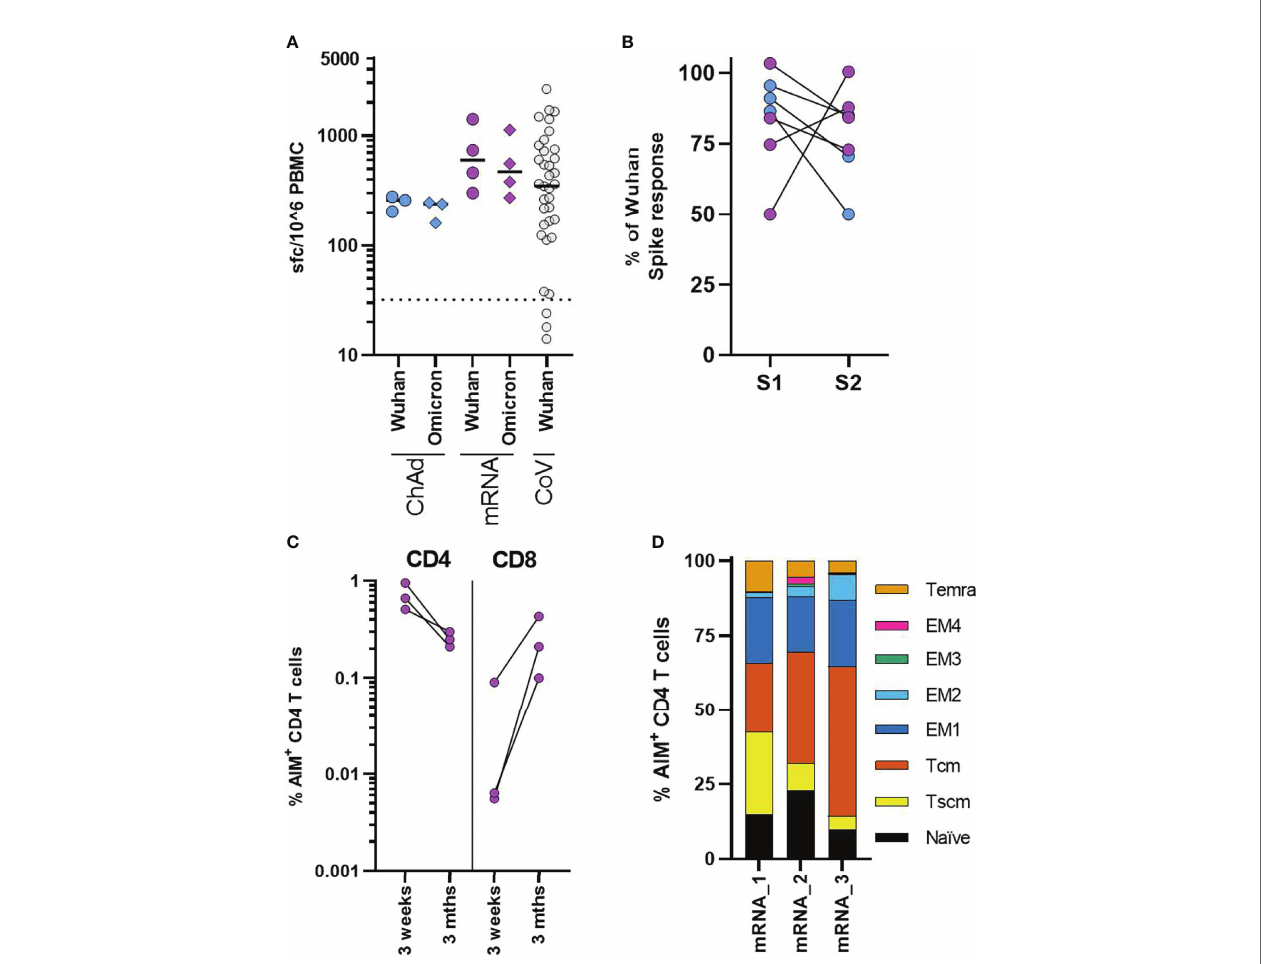
FIGURE 5 | Cellular responses in adolescents three months after COVID-19 vaccination. (A) Analysis of the T-cell response in ChAdOx1 (n = 3) and mRNA-1273 (n = 4) adolescents three months after second dose. Results from IFN g ELISpot assay are normalised to the DMSO control and expressed as spot forming cells (sfc) per million input PBMC. Response to overlapping peptide pools from Wuhan (circles) or B1.1.529 (diamonds) sequence spike protein. Results from previously published data from n = 37 seropositive children aged 4-11 are shown for comparison, dotted line indicates response threshold. (B) Shows the relative change in the response to peptide pools containing peptides from the S1 and S2 spike protein domains of Omicron, expressed relative to the size of the response to Wuhan sequence peptide pools. (C , D) A fl ow cytometry-based AIM assay was used to identify responding CD4 (CD69+CD40L+) and CD8 (CD69+CD137+) T-cell frequency following overnight stimulation with overlapping Wuhan spike peptides in three adolescents who received mRNA-1273 vaccination. (C) Dots indicate individual donors and frequency of AIM+ CD4 and CD8 T-cells following second dose of vaccine (3 weeks) or three months after second dose (3 Mths). (D) AIM+ CD4 T-cells, were phenotyped to assess memory state, bars represent indicate individual donors (numbered 1-3) and show the proportion of the AIM+ CD4 T-cell population. T effector memory (CD45RA-CCR7-, EM) are subdivided as EM1 – CD27+CD28+, EM2 – CD27+CD28-, EM3 – CD27-CD28-, EM4 -